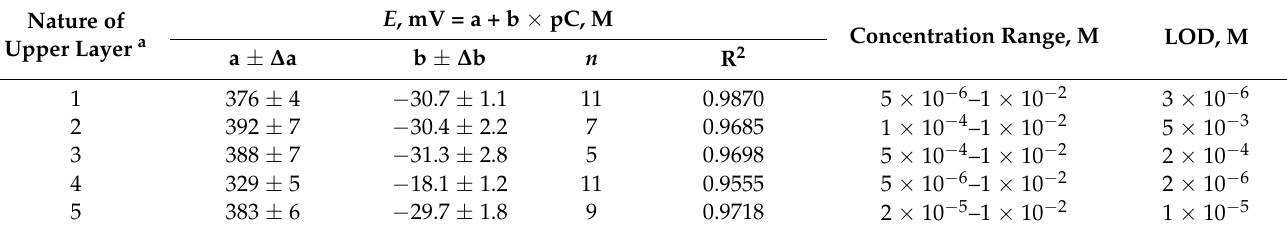
Figure 6. Calibration curves of Cu 2+ ions obtained with potentiometric sensor with five layers (1) and an additional upper layer: 2 mg/mL PSS (2), 1% Nafion (3), 3% glutaraldehyde (4), and 4.0 mM CuCl 2 (5). Table 2. Dependence of the analytical characteristics of Cu 2+ determination on the nature of the upper layer, GCE covered with polyaniline and (P[6]A–Cu 2+ )2–P[6]A—upper layer. Average results from individual sensors, measurements in triplicate in 0.1 M